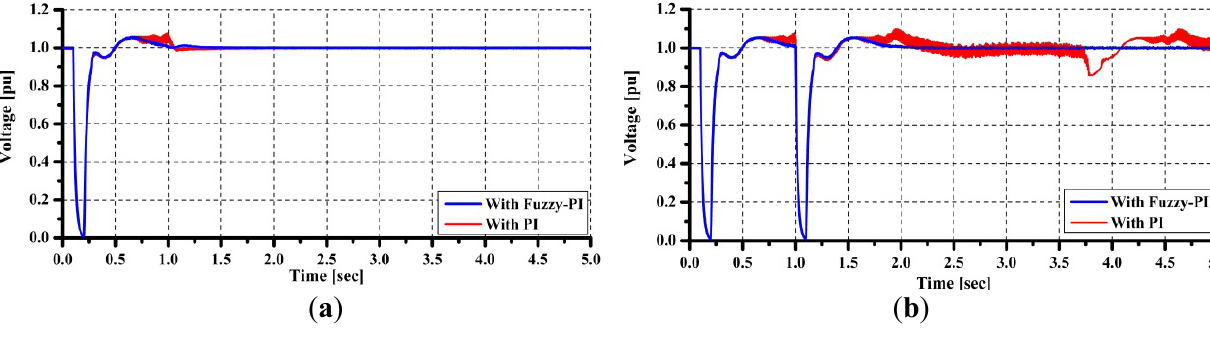
Figure 24. Rotor speed of IG. ( a ) case 1; ( b ) Case 2.